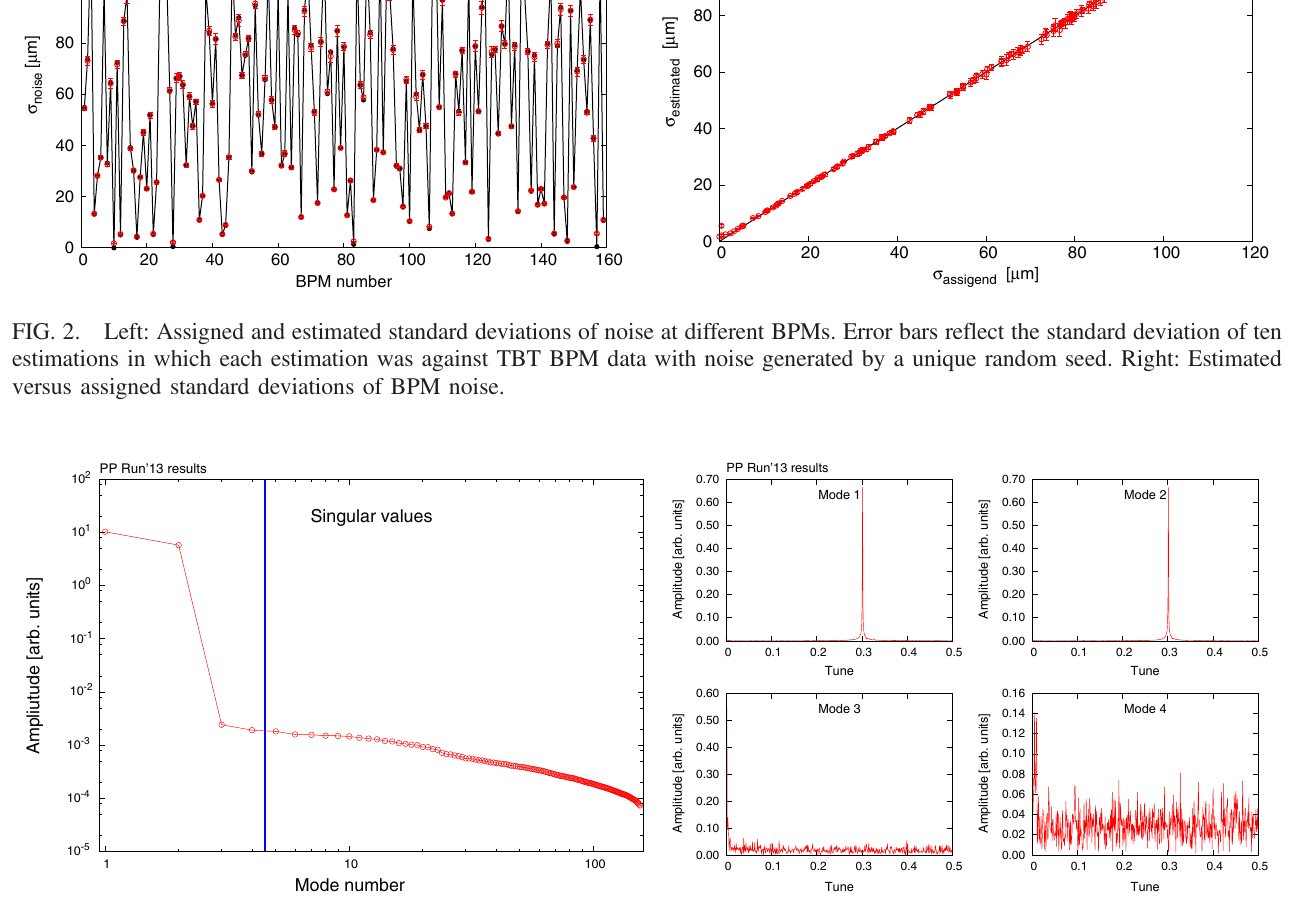
Table I. Histograms for the other estimated noise in Fig. 4 also show similar distributions.